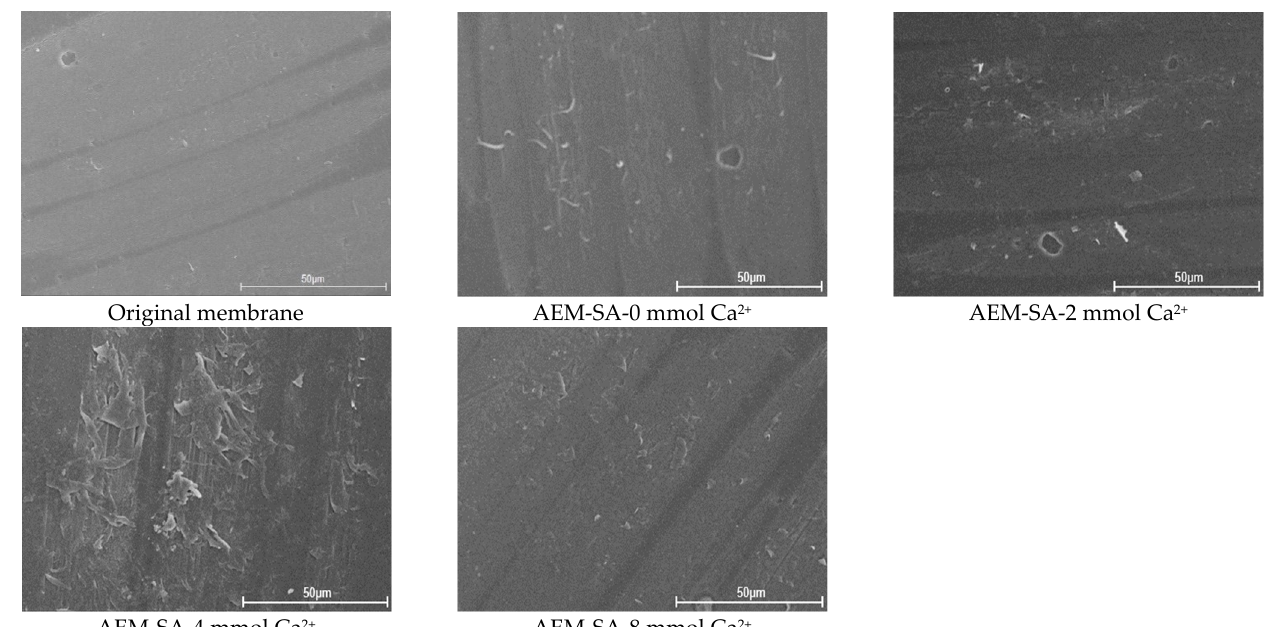
Figure 2. SEM images of original and used AEMs in the AEM-SA system with different calcium ion concentrations.